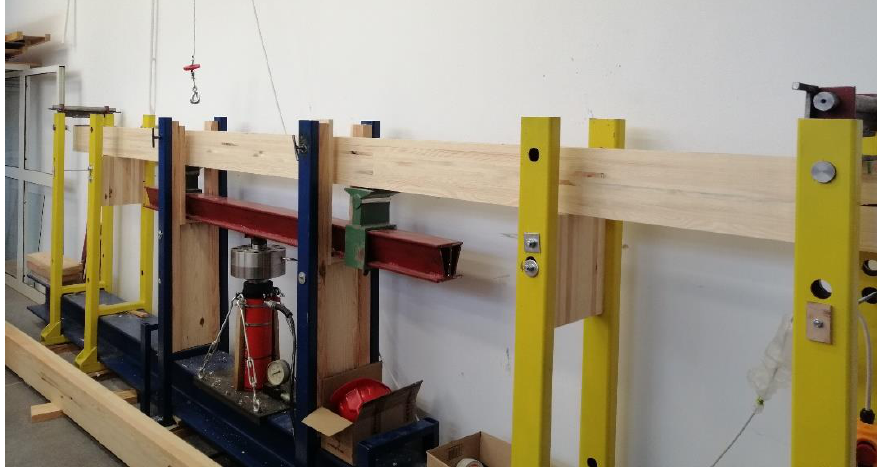
Figure 3. Test stand for the evaluations of the bending strength and modulus of elasticity.